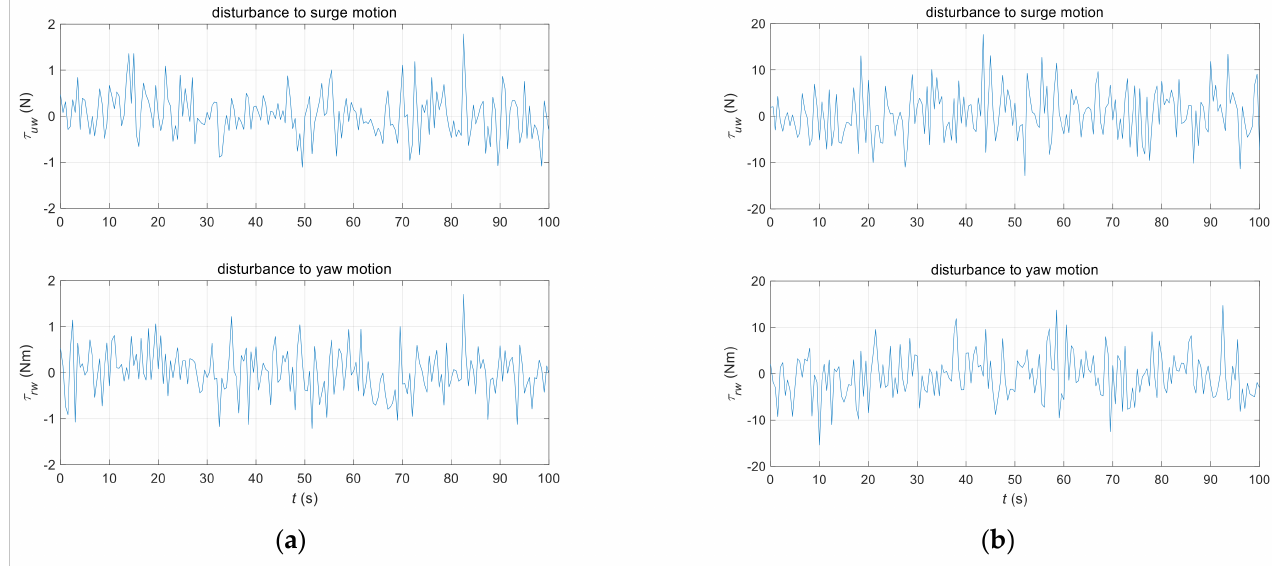
Figure 4. Disturbance force and moment. ( a ) Disturbances at the level of 0.5*randn; ( b ) disturbances at the level of